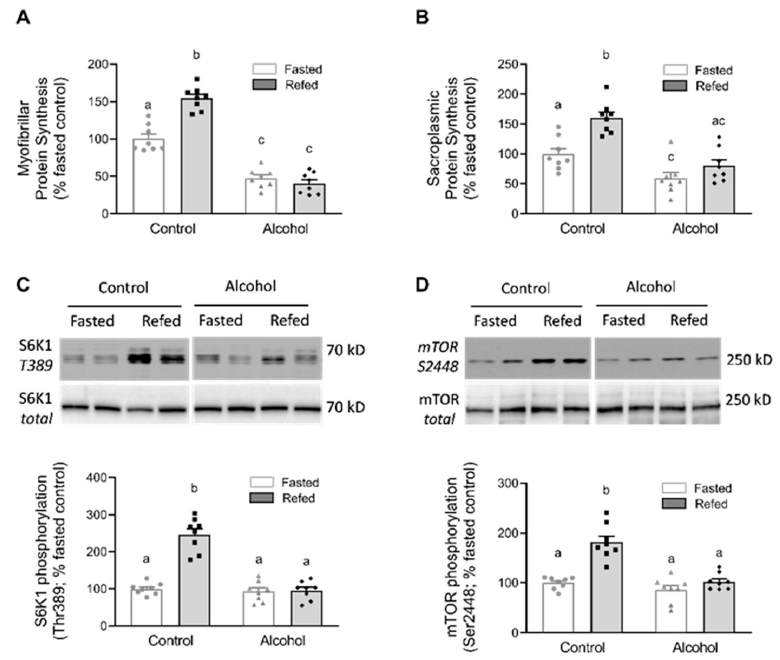
Figure 1. Relative rates of myofibrillar ( A ) and sarcoplasmic ( B ) protein synthesis in fractions isolated from the skeletal muscle of control and alcohol-receiving mice that have been either fasted or refed. Alterations in the total and phosphorylation of S6K-1 and mTOR protein abundance pro- duced by feeding and/or alcohol are also presented ( C , D ), respectively. A representative im- munoblot for each protein is displayed on top of the respective bar graph summarizing data from all samples analyzed. Although samples from all groups were loaded on the same gel, a gel break depicts lane(s) of the gel that have been deleted. Bar graphs represent analyses for all immunob- lots, where the mean of the fasted saline-treated control group was arbitrarily set at 100 arbitrary units (AU). Values are mean ± SEM with n = 8/group. Only values having different superscript letters are statistically ( p < 0.05) different. The reduction in mTORC1 activity in alcohol-treated mice after refeeding could re- sult from lower circulating and/or intracellular concentrations of leucine. However, alco- hol did not alter the plasma leucine in the basal fasted condition or the increased plasma leucine detected after refeeding (Figure 2A). Likewise, there was no difference in the in- tracellular leucine content in muscle from control and alcohol-treated mice under either fasting or refed conditions (Figure 2B). Differences between the two alcohol-treated groups could not be explained by differences in BAC as these did not differ between the fasted + alcohol (28 ± 4 mM) and the refed + alcohol (30 ± 5 mM) groups. An increase in plasma or tissue glutamine can also increase protein synthesis [21]. However, there was no effect of alcohol and/or refeeding on either the plasma or intracellular glutamine con- centrations in skeletal muscle (Figure 2C,D).